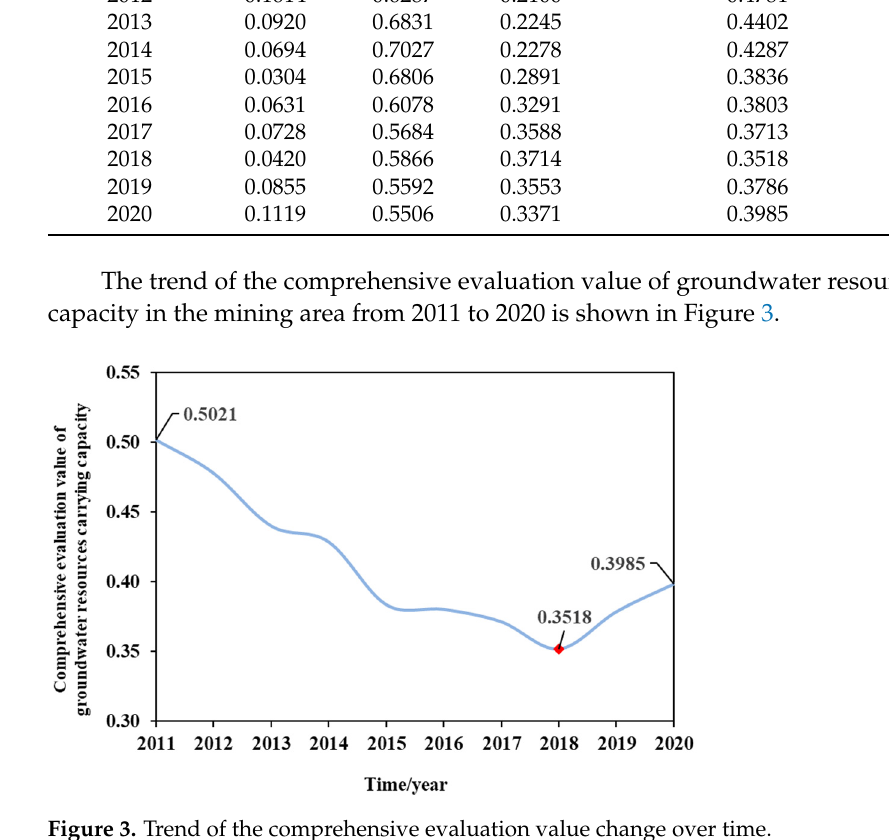
Figure 3. Trend of the comprehensive evaluation value change over time.